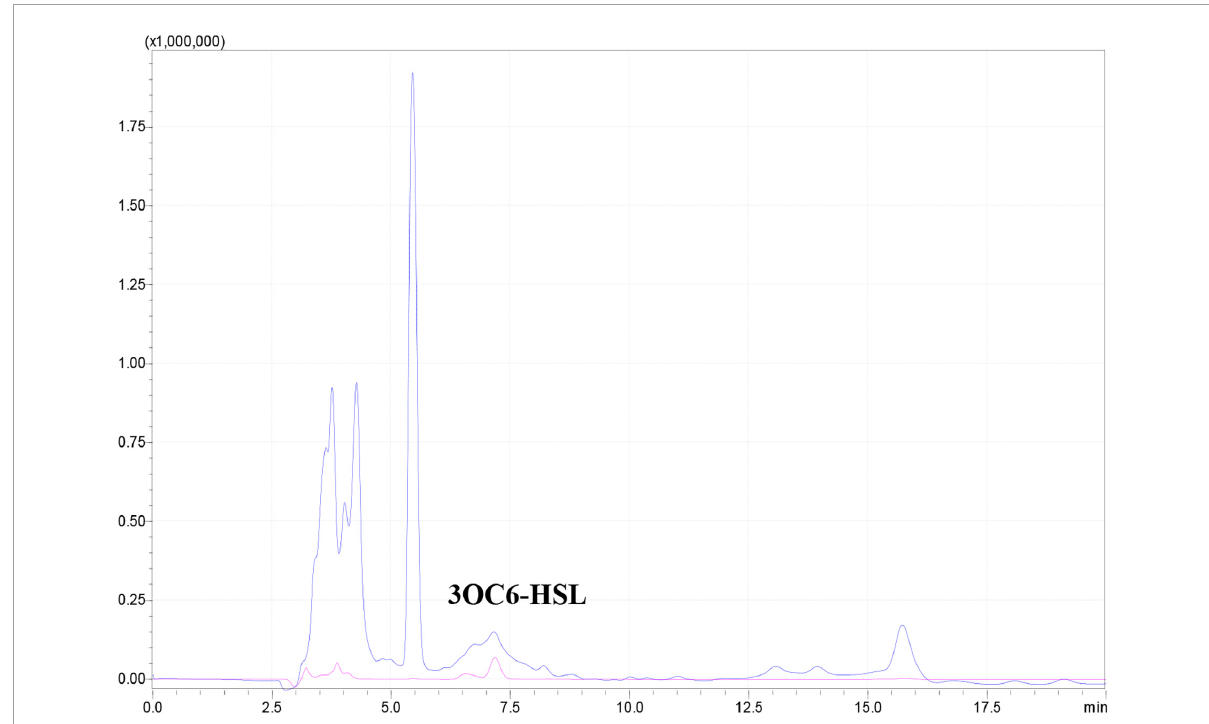
FIGURE8 3OC6-HSL produced by Dickeya zeae strain WH1 measured by HPLC. Blue indicates 3OC6-HSL present in the supernatant from D. zeae strain WH1; pink indicates commercial 3OC6-HSL standard.